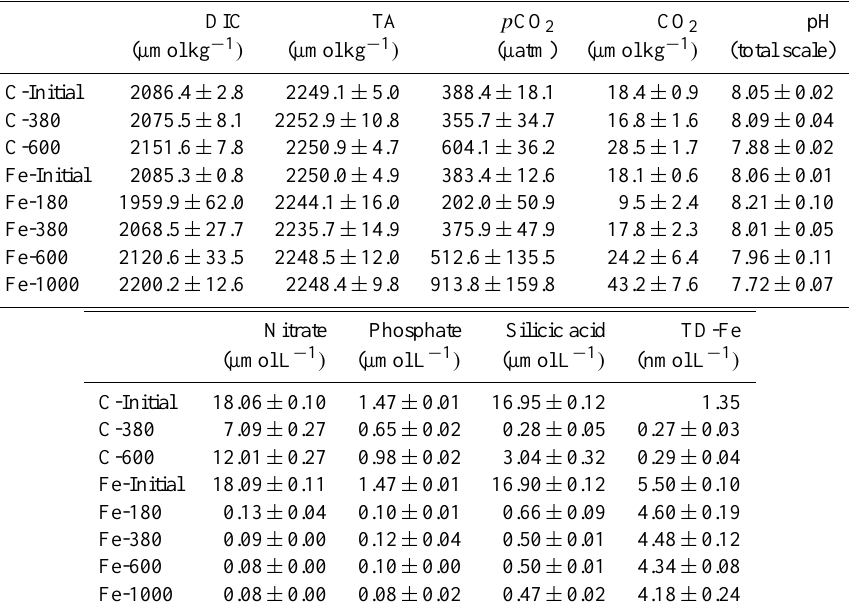
Table 1. Carbonate chemistry, nutrients, and Fe parameters (value ± 1 standard deviation, n = 3) during the incubation experiment. Carbonate parameters are the initial and mean values throughout the incubation. Macronutrients and Fe parameters are the values at the initial or final sampling days (i.e., day 5 for the control and day 6 for the Fe-added treatments). Standard deviation was not assessed for initial TD-Fe concentration because samples were collected from single source. See Figs. S1 and S2 for the complete data set. DIC TA p CO 2 CO 2 pH (µmolkg − 1